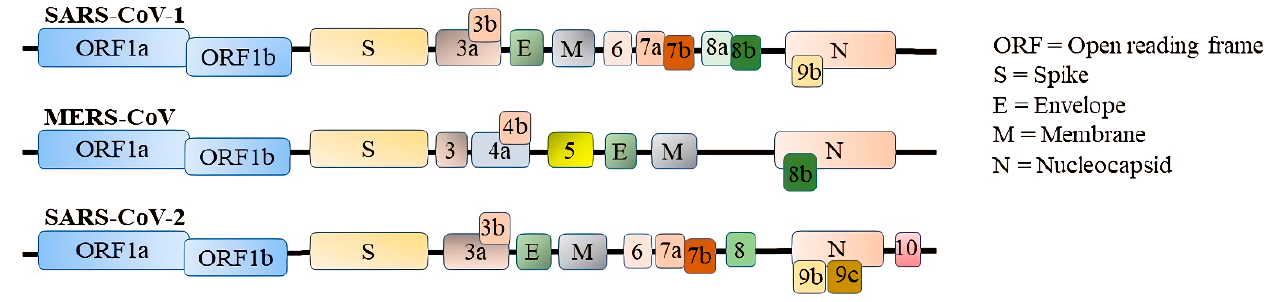
Figure 1. The CoVs structure, including ORF1a/b, structural proteins, and accessory proteins.